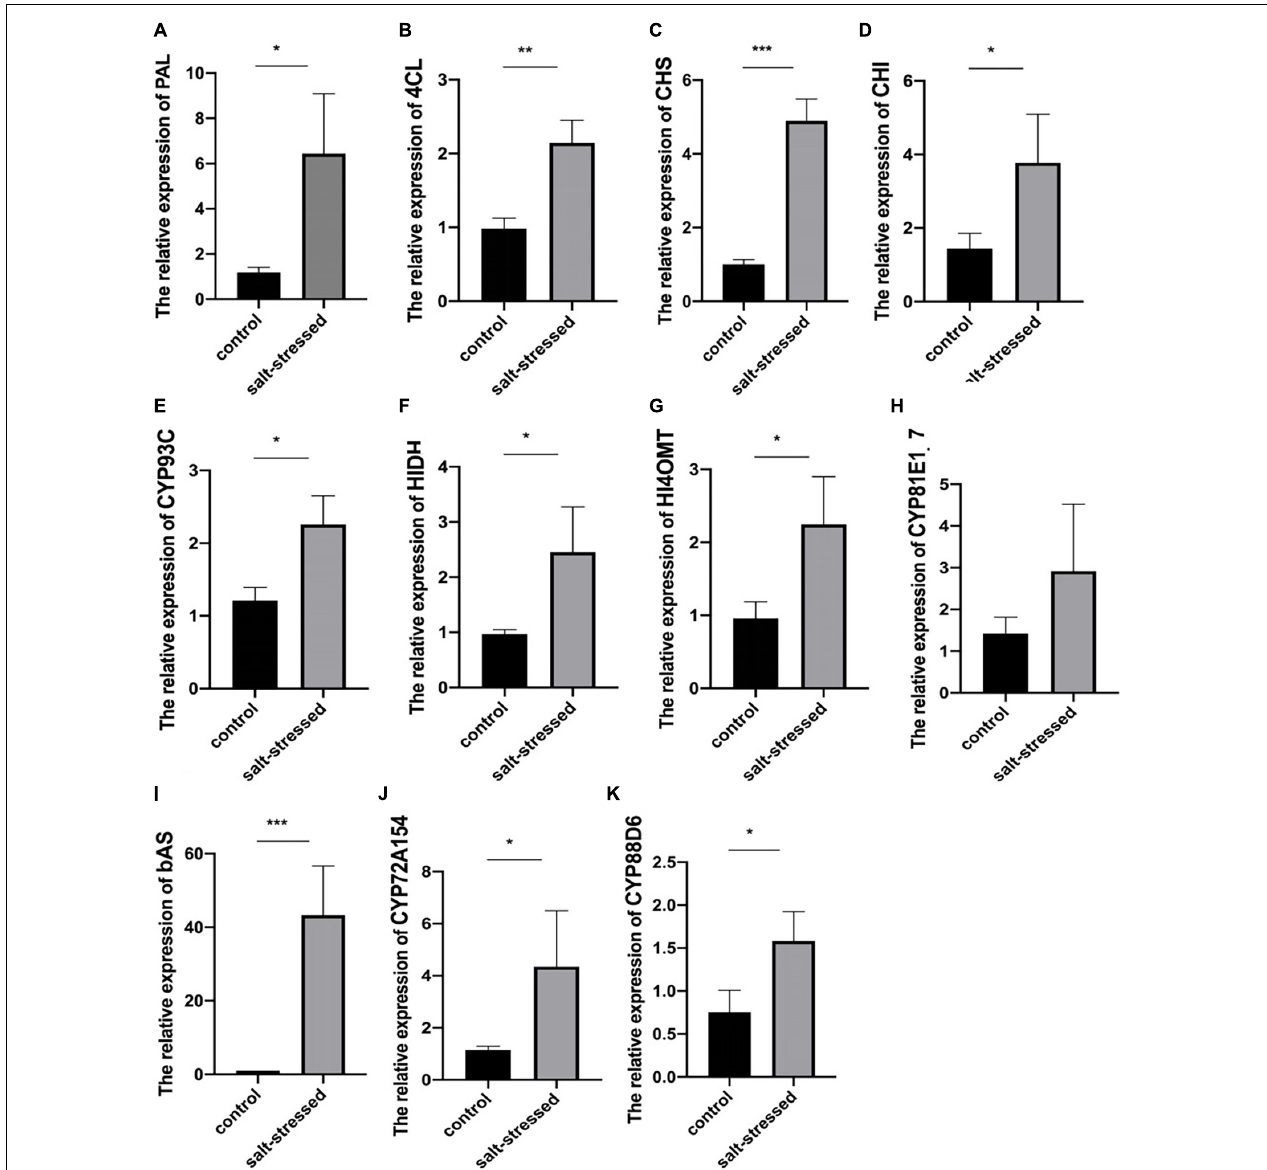
FIGURE 6 | Difference in the expression levels of (A) PAL, (B) 4CL, (C) CHS, (D) CHI, (E) CYP93C, (F) HIDH, (G) HI4OMT, (H) CYP81E1_7, (I) bAS, (J) CYP72A154, and (K) CYP88D6 between salt-stressed and control groups [means ± standard deviation (SD); * p < 0.05, ** p < 0.01, and *** p <